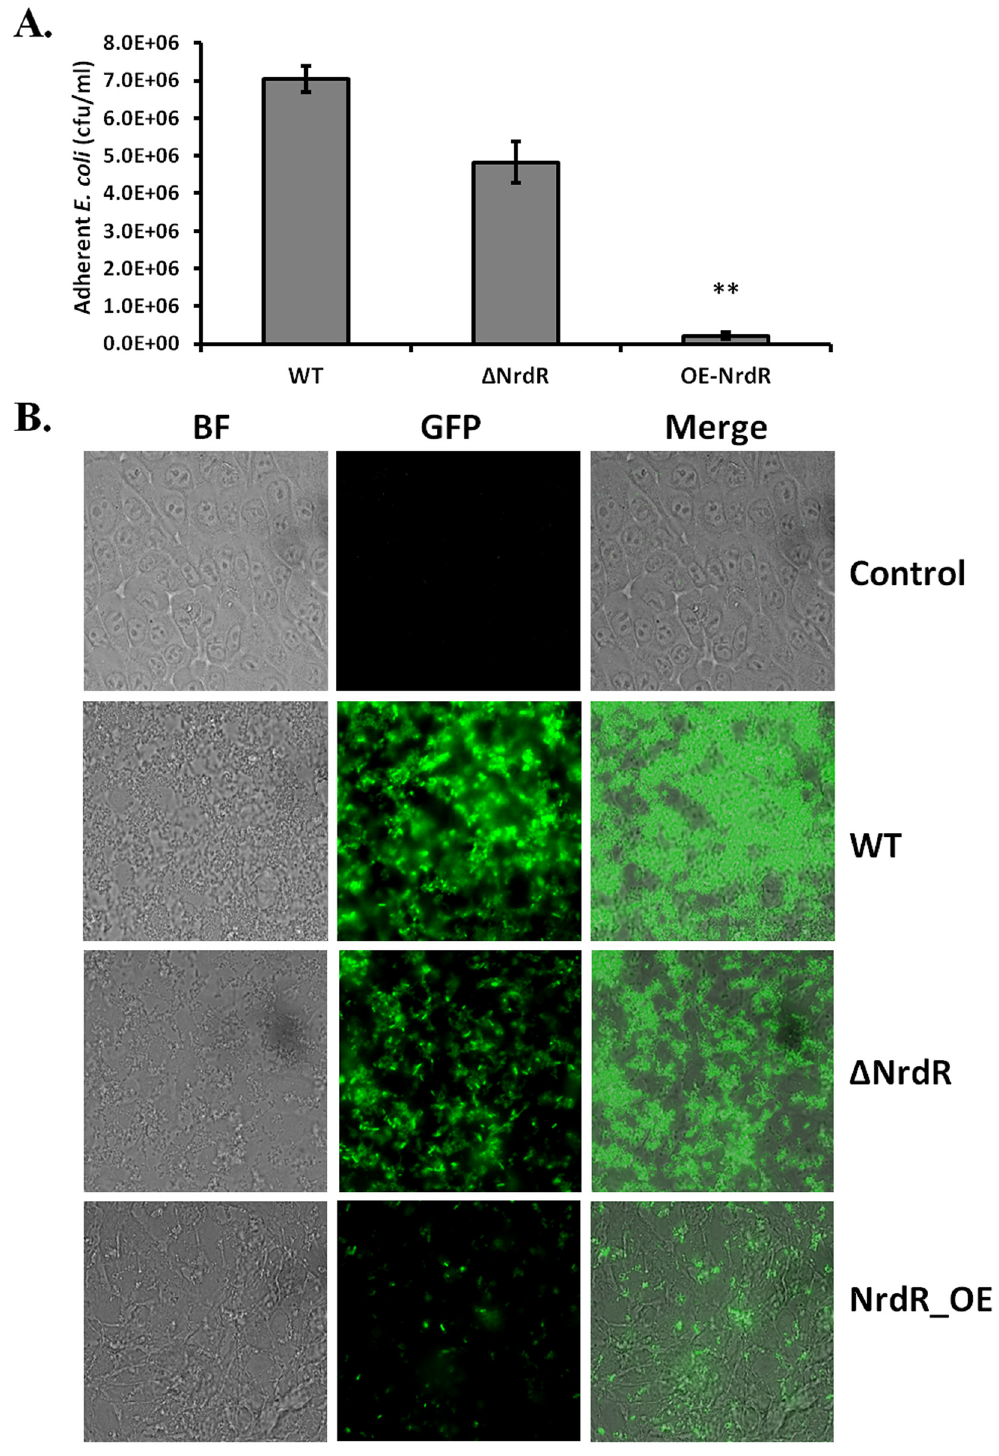
Fig 8. Bacterial NrdR regulates adhesion to mammalian epithelial cells. (A) Human epithelial cells in culture were infected with WT, Δ NrdR and OE-NrdR E . coli strains. Adherent bacteria were counted 3 hours after infection. Results are reported as CFUs/ml. (B) Direct observation of GFP-tagged WT, Δ NrdR and OE-NrdR E . coli adhering to mammalian cells by fluorescent microscopy at ×1000 magnification. The GFP signals were observed under the FITC filter of a UV laser at